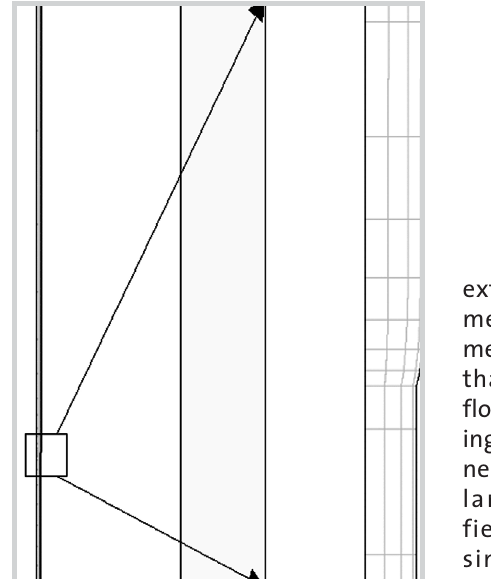
Figure 4 (left): Typical simulation results. Figure 5 (right above): Typical ESR plot against downstream distance. Figure 6 (right below): Effect of relaxation spec- trum range on extrudate swell